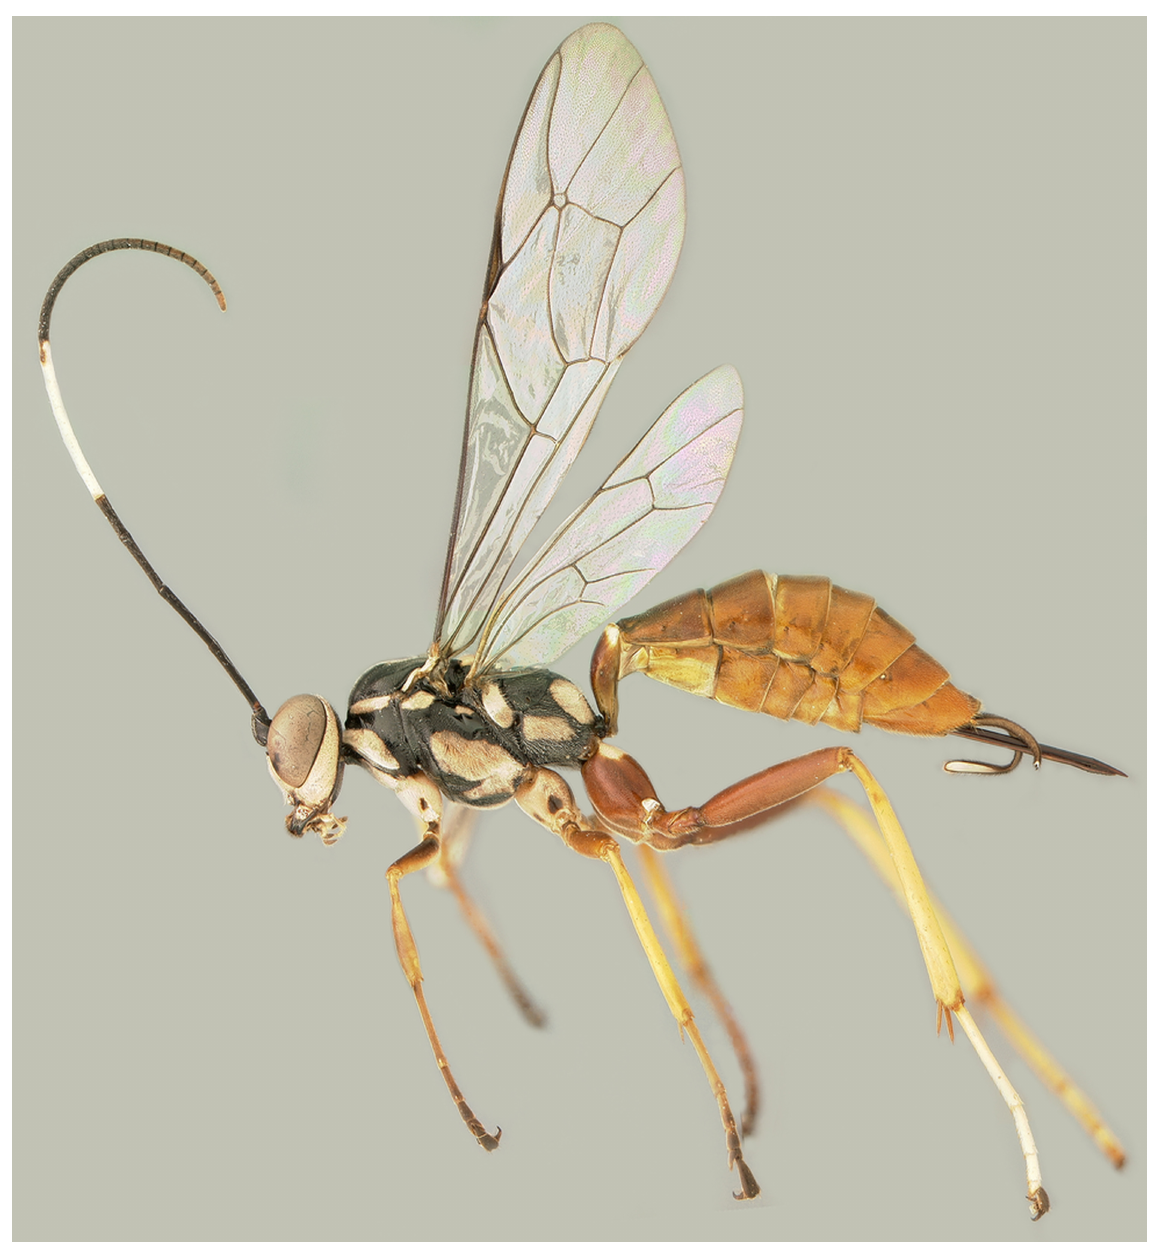
Fig. 2. Distictus paratibialis sp. nov., holotype (LAPIS5907), ♀, habitus. Photo by Berthil B.